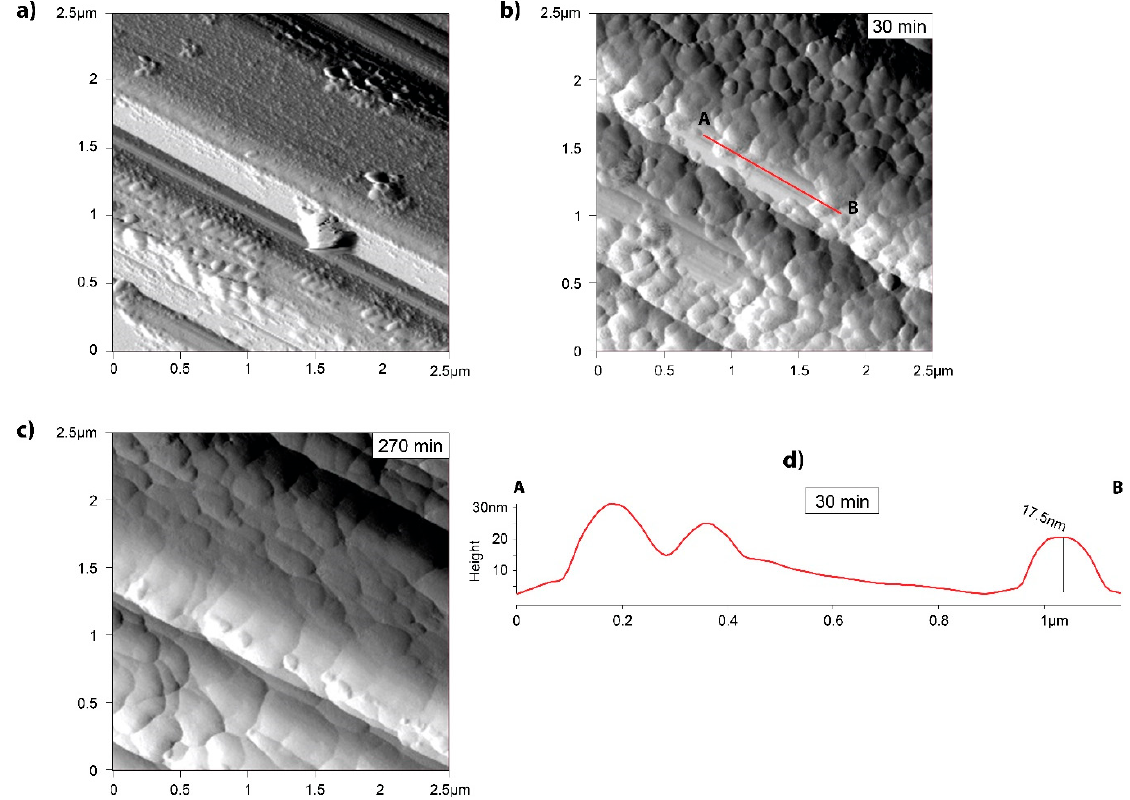
Figure 10. Amplitude retrace AFM images of same area on erionite surface at 37 °C, ( a ) in water and at different interaction time in Gamble’s solution (pH 8.48): ( b ) after 30 min; ( c ) after 270 min. A layer growth is recognizable, and the height of this new phase is showed in the related section ( d ).